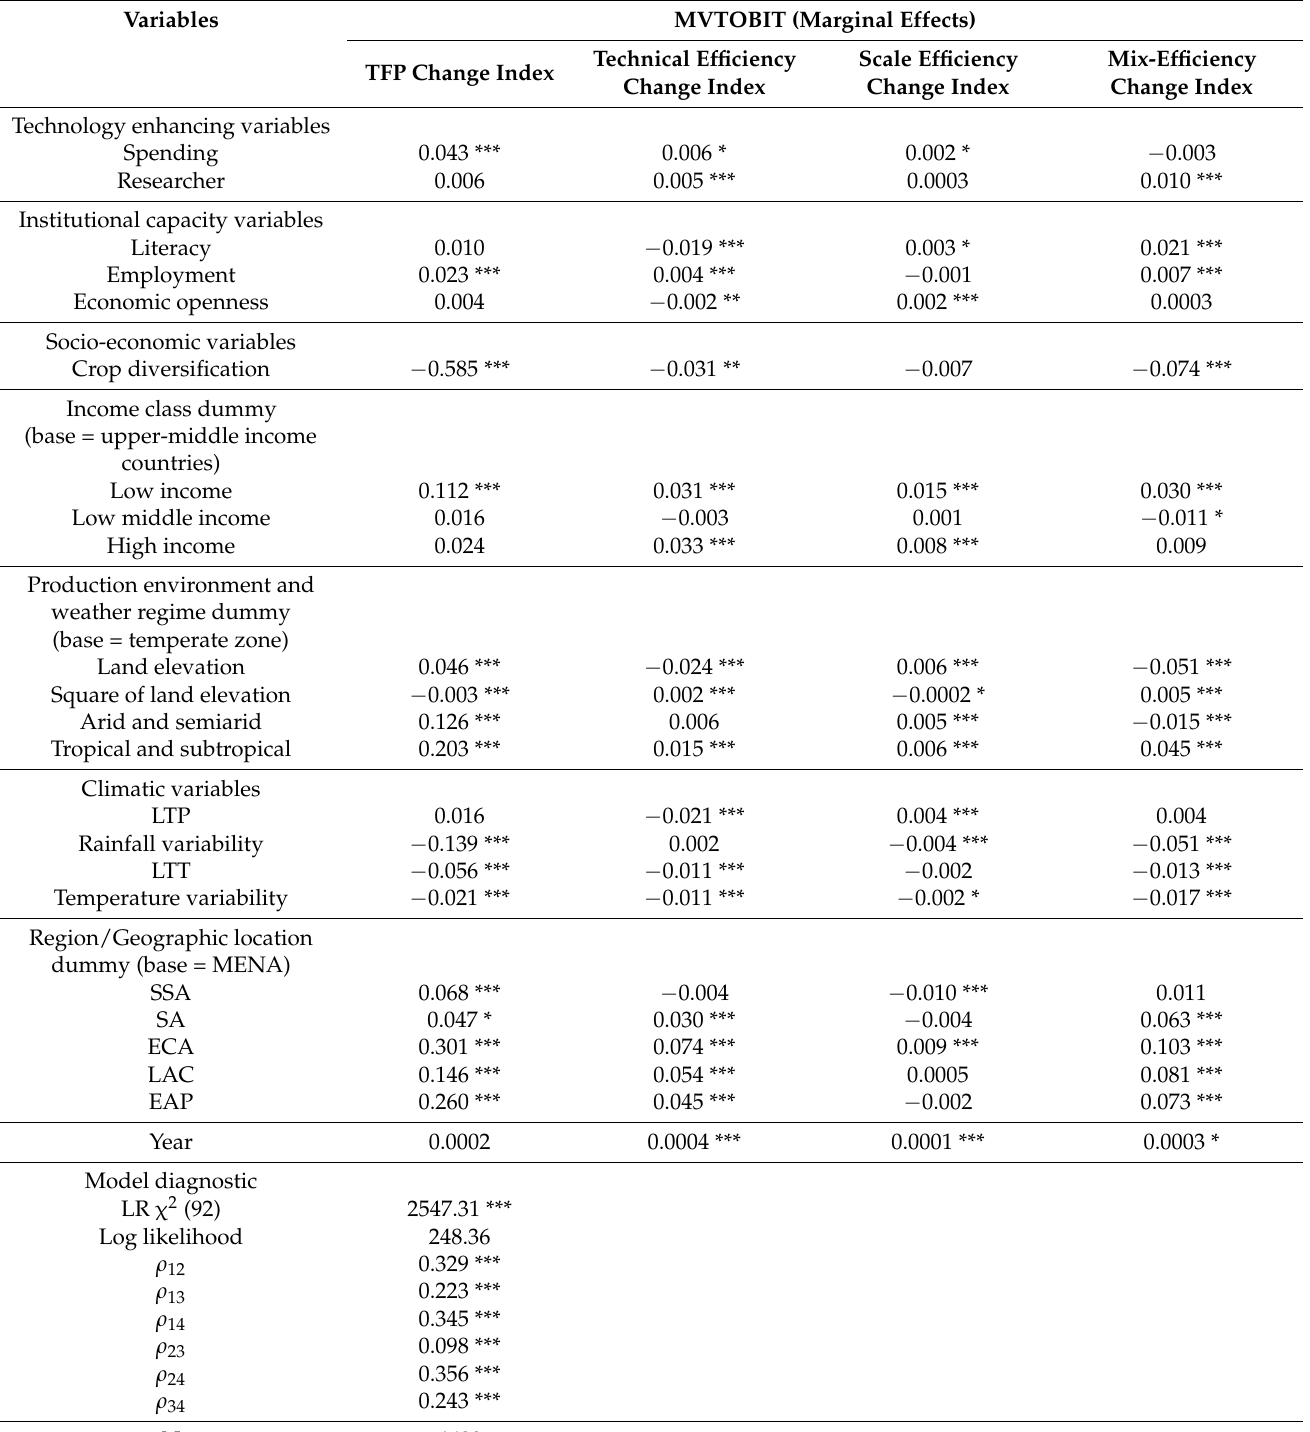
Table 4. Joint estimation of the determinants of TFP change and its